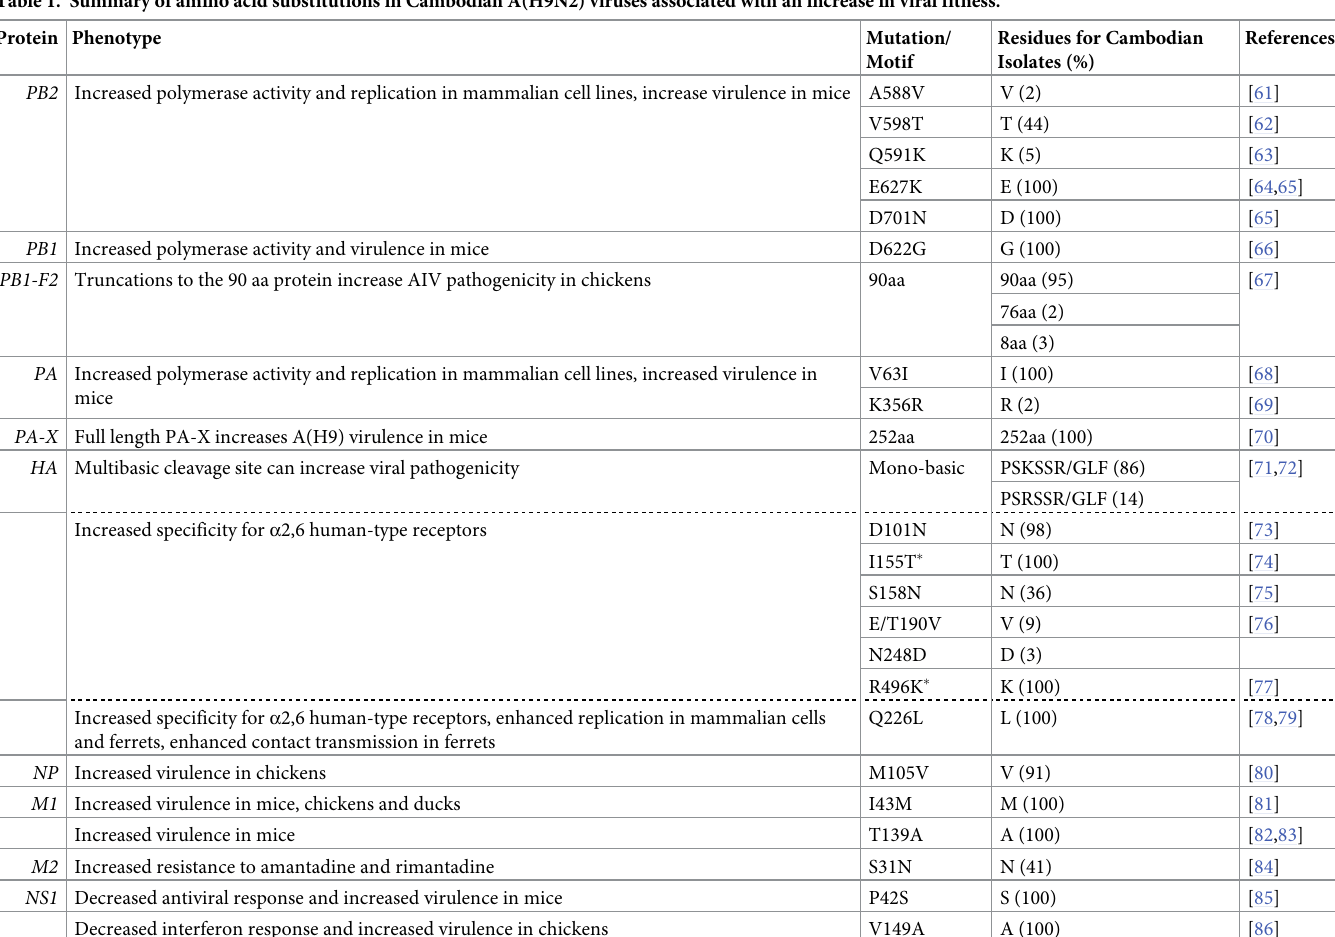
Table 1. Summary of amino acid substitutions in Cambodian A(H9N2) viruses associated with an increase in viral fitness. Protein